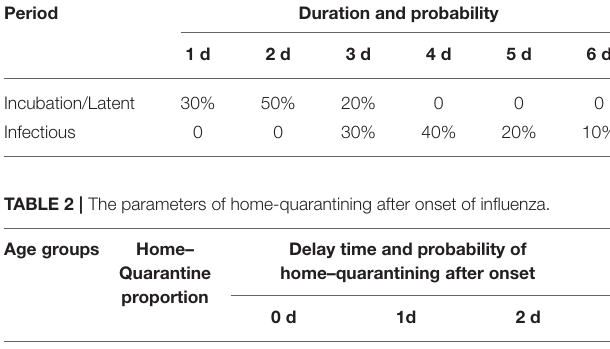
TABLE 1 | The duration and probability distribution of exposed and infection period in the model. Period